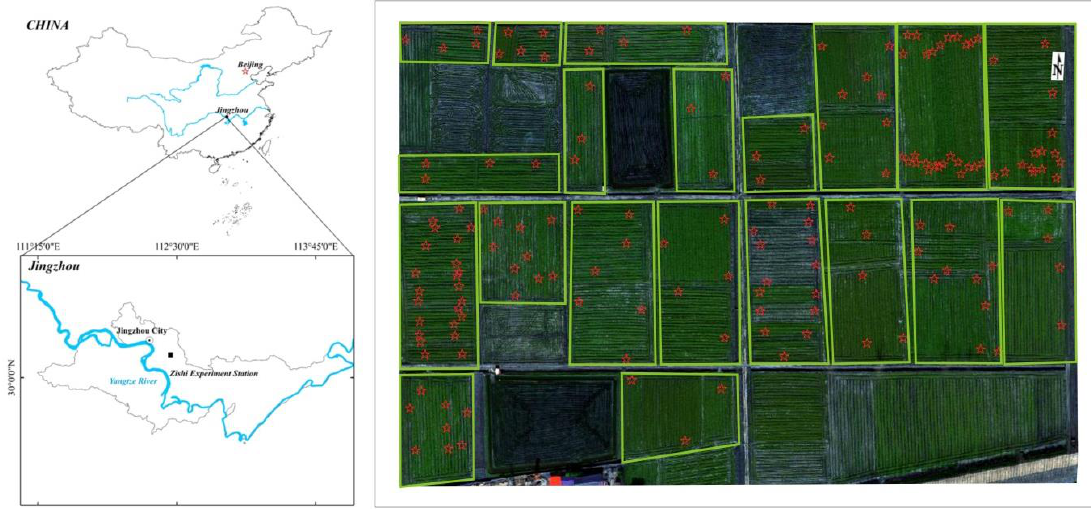
Figure 1. Zishi experimental station and field view.